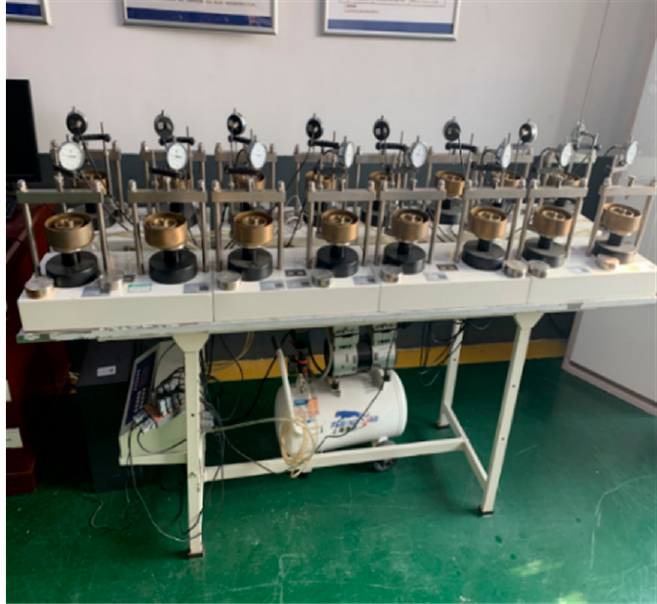
Figure 2. Automatic pneumatic consolidation instrument (16 containers).